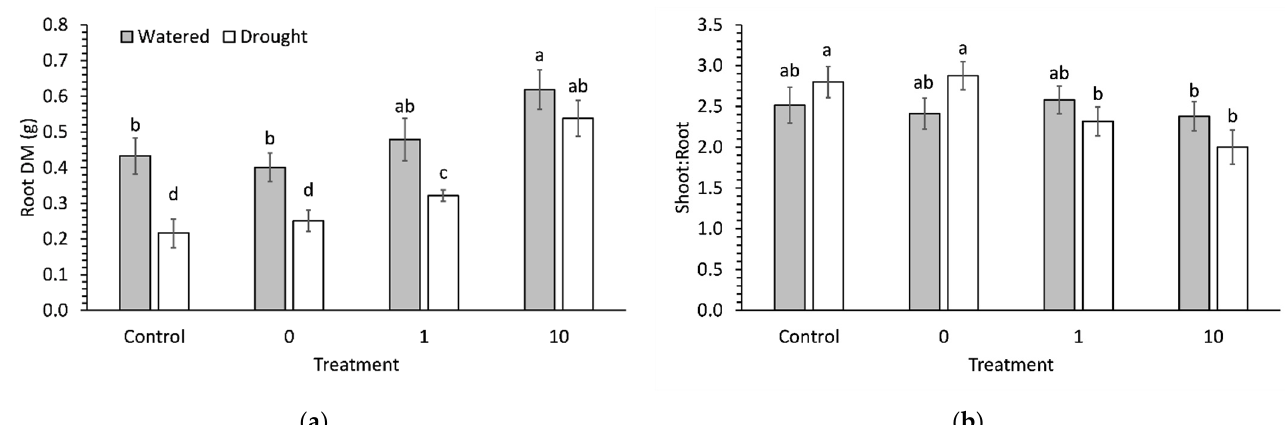
Figure 4. ( a ) Root biomass and ( b ) shoot:root ratio in 9-week-old broccoli seedlings which were watered or deprived of water for 1 week. Each bar represents a mean and error bars represent standard error calculated from 9 replicates. Means with different letters are significantly different ( p < 0.05) as determined by Tukey’s honestly significant difference.